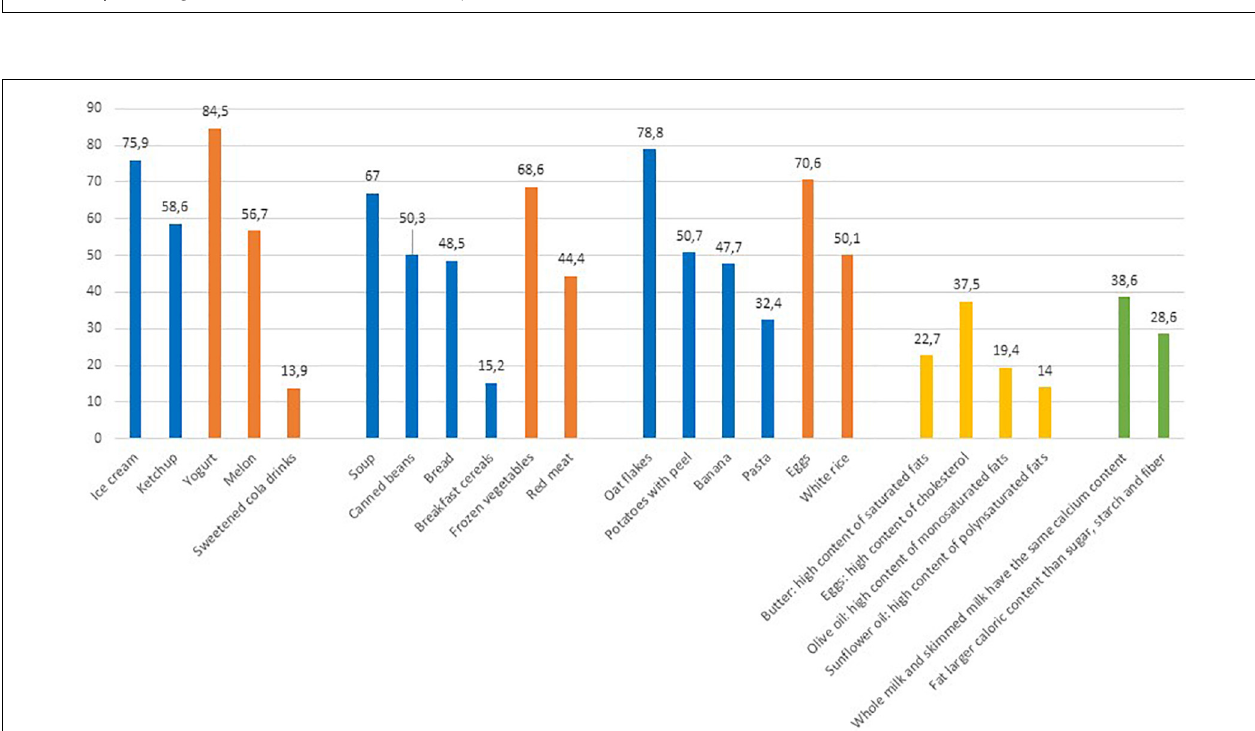
FIGURE 2 | Percentages of correct answers to selected questions of NK2-food composition section. The reported items were those with the general lowest scoring.